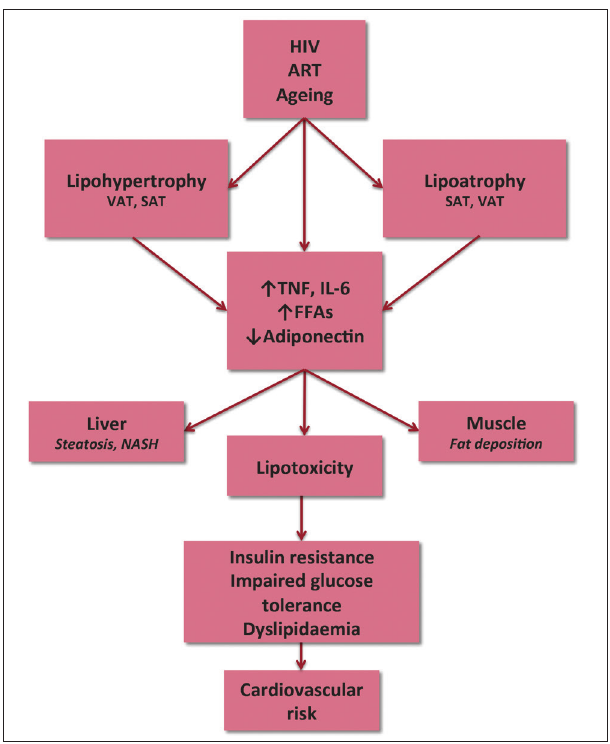
Fig. 2. Metabolic consequences of lipodystrophy. VAT = visceral adipose tissue; SAT = subcutaneous adipose tissue; TNF = tumour necrosis factor; IL-6 = interleukin-6; FFAs = free fatty acids; NASH = Non-alcoholic